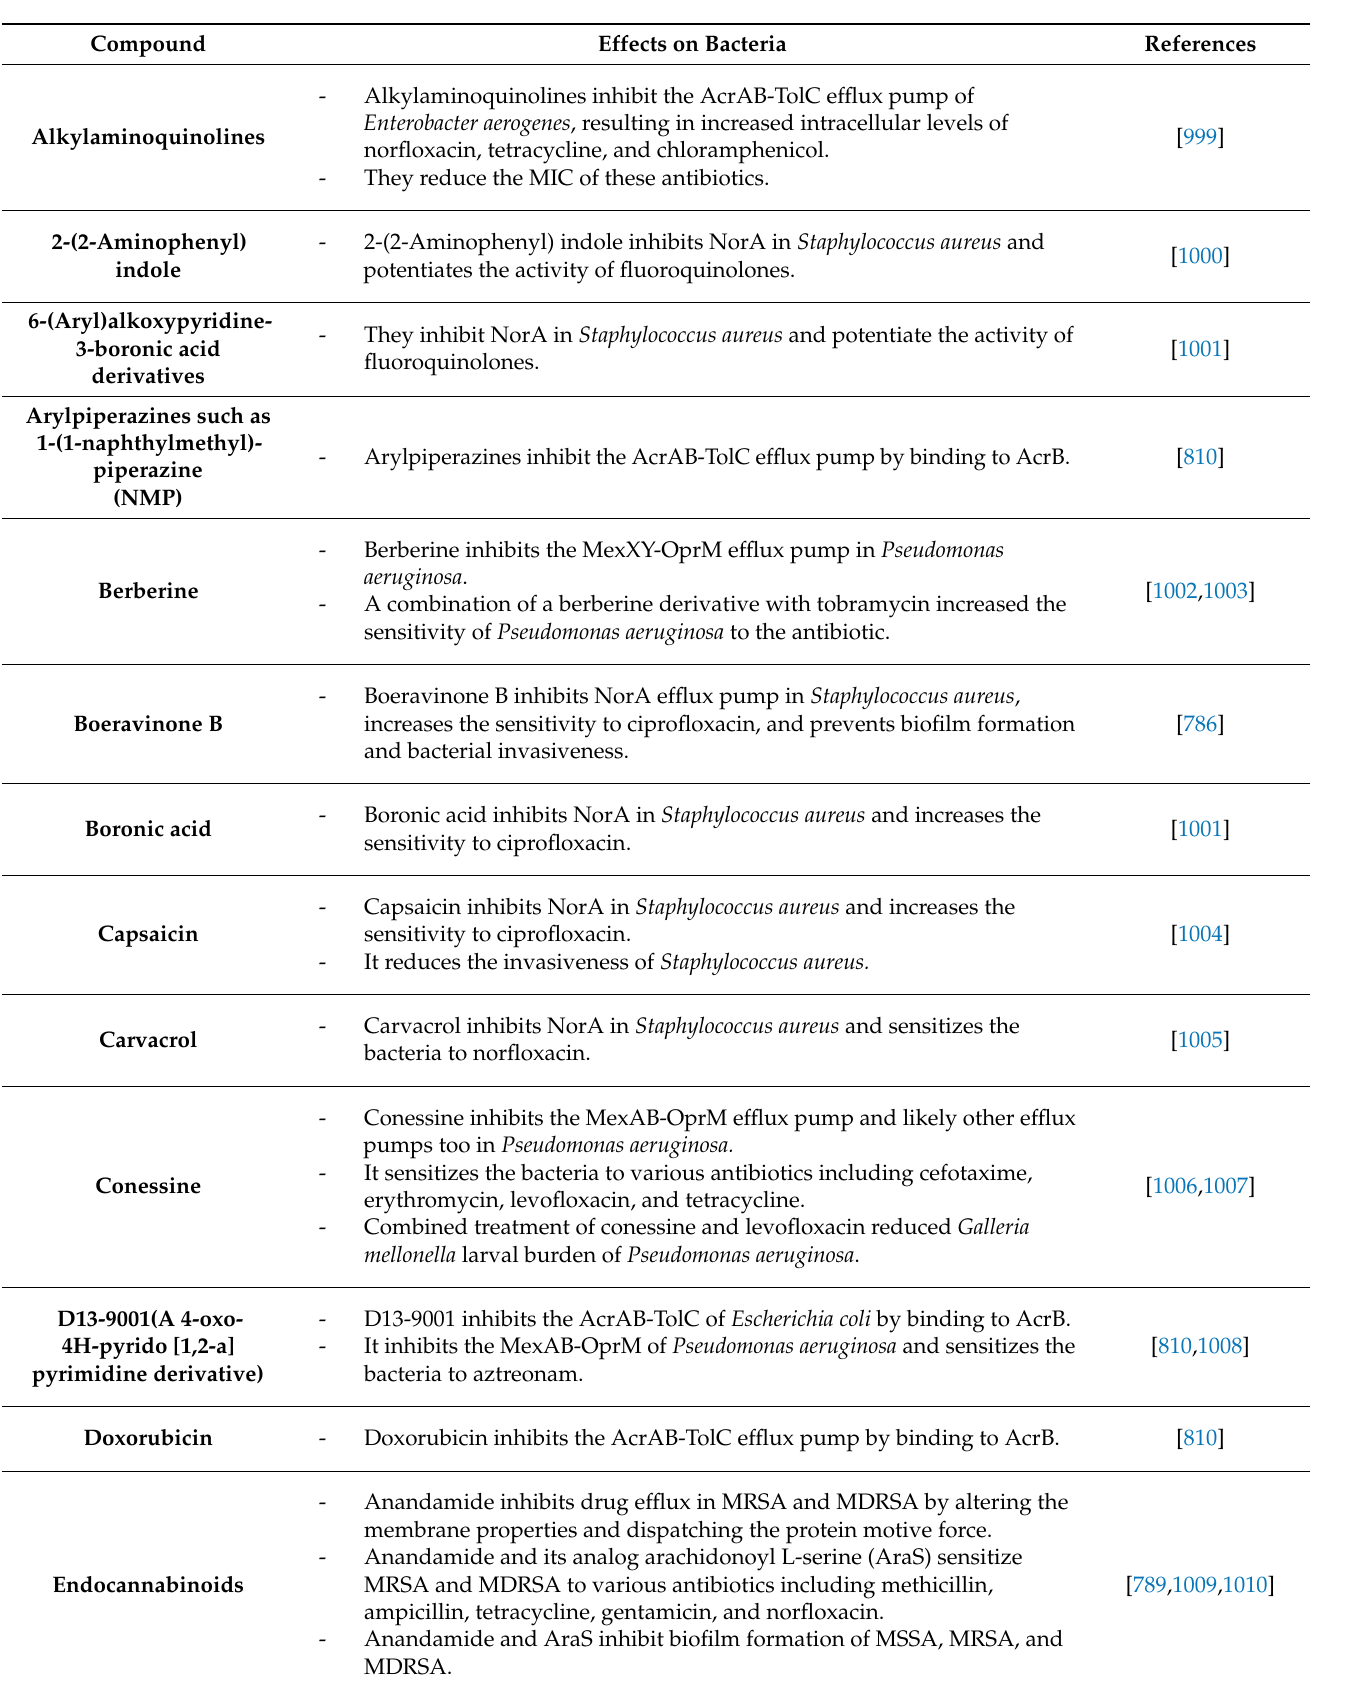
Table 6. Examples of efflux pump inhibitors (EPIs) 1